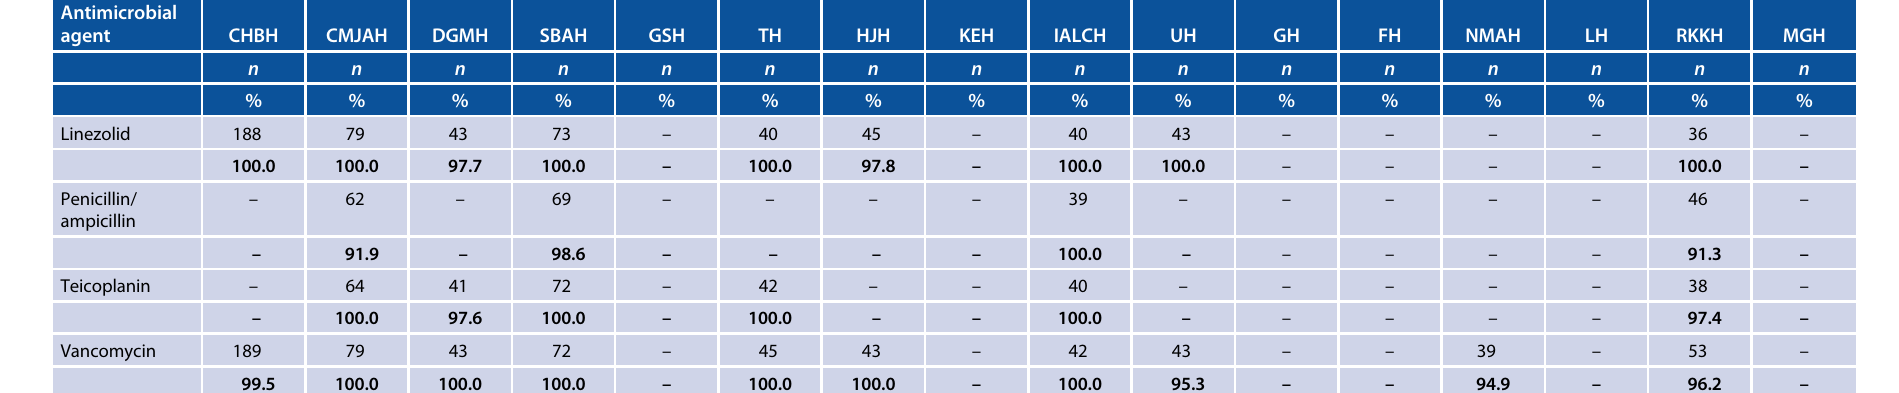
Table 10: Number and percentage of susceptible Enterococcus faecalis isolates per antimicrobial agent from 16 sentinel hospitals across South Africa, January 1, 2016 to December 31, 2016 Antimicrobial agent